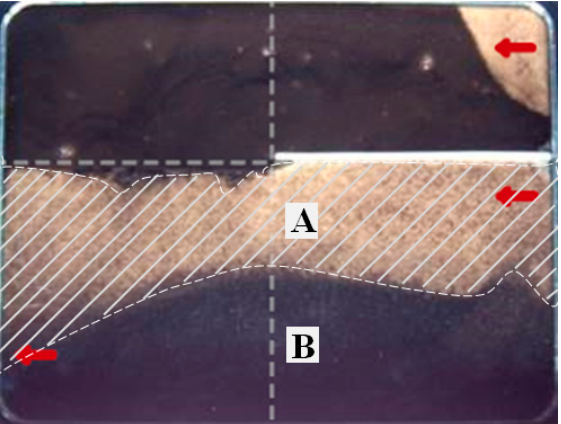
Figure 6. Distribution of remaining oil in high-permeability layer when gas preferential pathway is formed. (A—Displacement area channel; B—remaining oil distribution area). (The arrow at the right side is the injection end; the arrow at the left side is the production end).